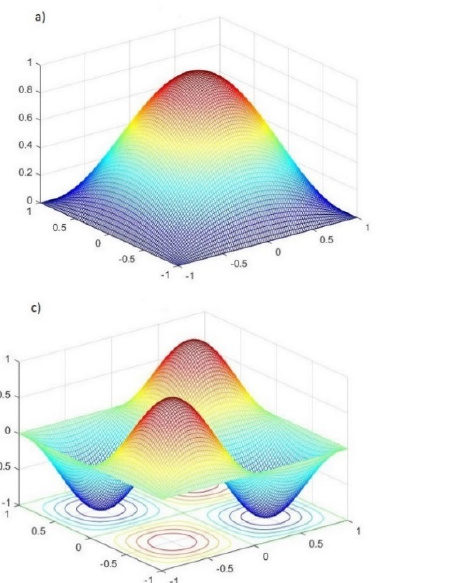
Figure 9. Vibrational modes for USFG distribution without the agglomeration effect: ( a ) 1st mode, ( b ) 2nd mode, ( c ) 3rd mode, ( d ) 4th mode, ( e ) 5th mode.